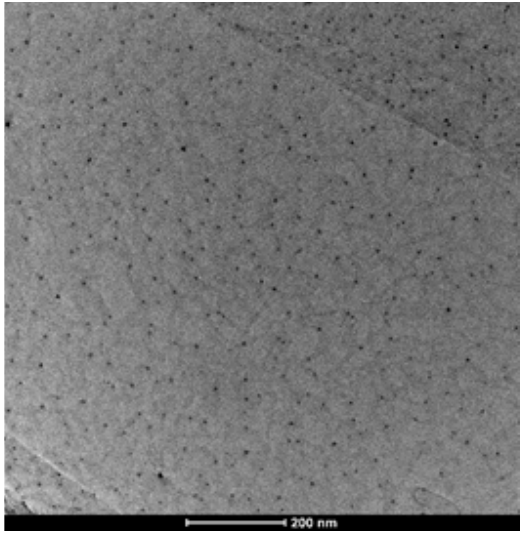
Figure 3. TEM image of CVD grown monolayer graphene.